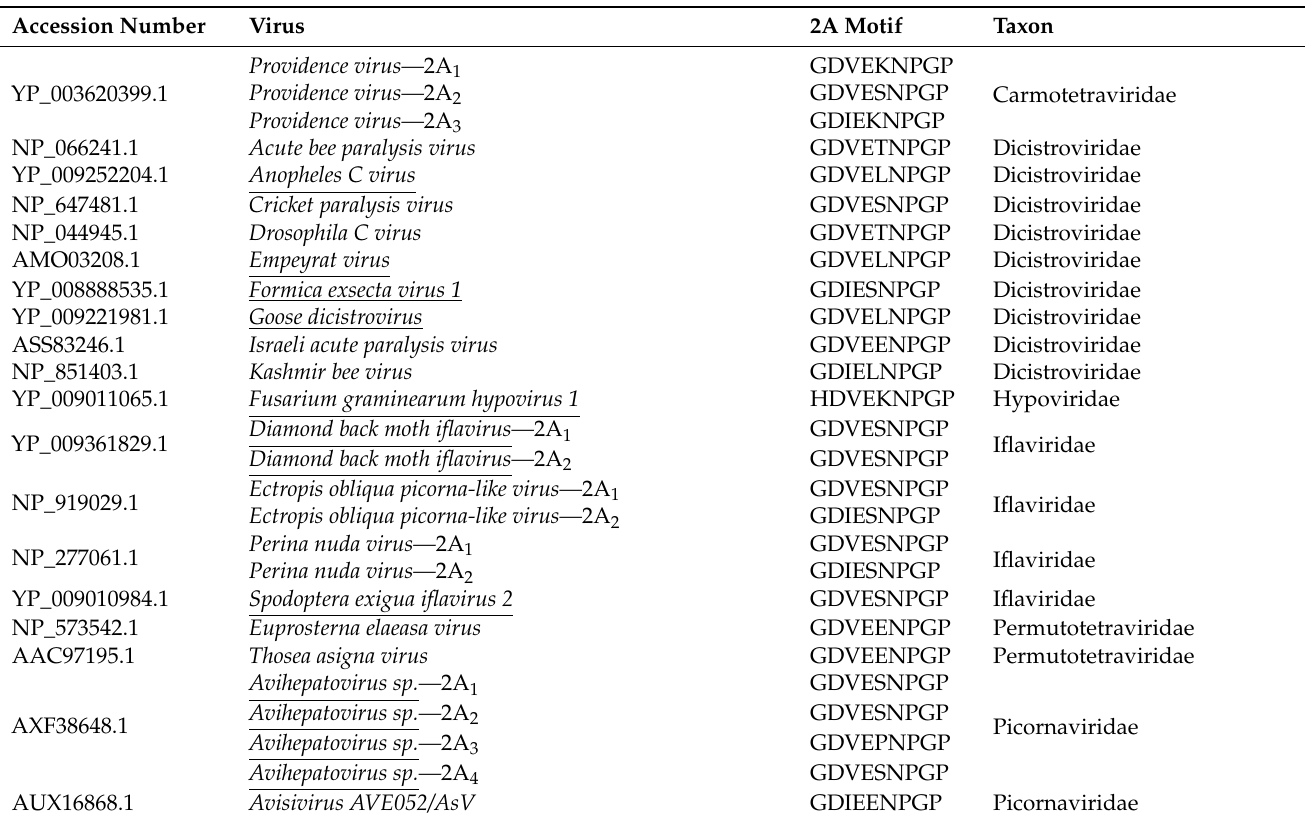
Table 2. Positive-sense single-stranded RNA virus containing 2A-like